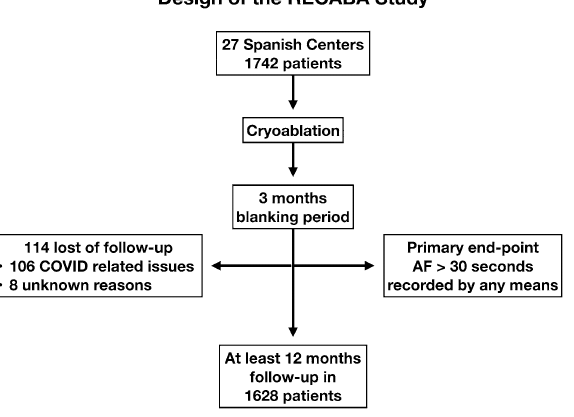
Figure 1. Visual representation of RECABA